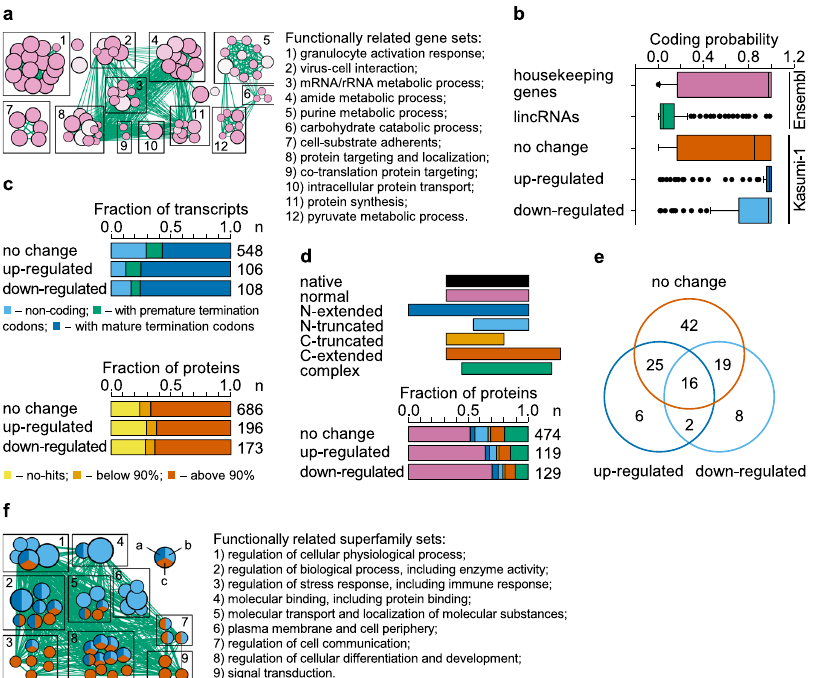
Fig. 6 Fusion protein-controlled differential splicing expands the protein space. a Enrichment map of the Gene Ontology-enriched gene sets across all the genes with differential expression and/or differential splicing. Nodes represent signi fi cantly enriched gene sets and node size is proportional to the number of members in a gene set. Edges indicate the gene overlap between the nodes, and the thickness of the edges is equivalent to the degree of the gene overlap between the nodes. Functionally related gene sets are clustered and named. b Box plot depicting the coding potential of 500 randomly selected transcripts each from housekeeping genes and lincRNA genes, and all 752 transcripts of genes affected by differential splicing in Kasumi-1 cells. In each boxplot, horizontal line represents the median of probability distribution, box shows the interquartile range, and whiskers are the minimum and maximum. c Column graphs depicting the classi fi cation of coding sequences in transcripts (upper panel) and of in silico translated proteins (lower panel) affected by differential splicing. In the upper panel, all transcripts were classi fi ed on non-coding (no signi fi cant open reading frames were found), protein- coding with premature termination codons and protein-coding with mature termination codons. In the bottom panel, all protein-coding transcripts were in silico translated and predicted proteins were blastp aligned against non-redundant set of human proteins. Protein identities are indicated at the bottom. d Column graphs showing the impact of RUNX1/RUNX1T1 on the frequency of protein variants. e Venn diagramme visualizing the distribution of the 118 domain superfamilies among the in silico predicted proteins. f Enrichment map of the domain-centered Gene Ontology-enriched superfamily sets across all the genes with differential splicing. Nodes represent signi fi cantly enriched superfamily sets and node size is proportional to the number of members in a superfamily set. Edges indicate the superfamily overlap between the nodes, and the thickness of the edges is equivalent to the degree of the superfamily overlap between the nodes. Functionally related superfamily sets are clustered and named. Pie chart coloring: (a) upregulated, (b) downregulated, and (c) no